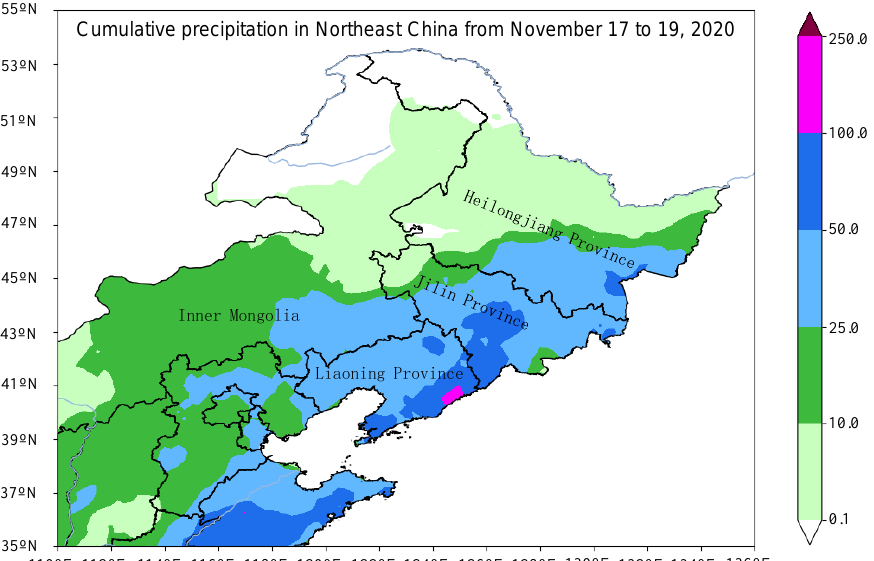
Figure 1. Cumulative precipitation in northeast China from 17 to 19 November 2020 (fill color, unit: mm).